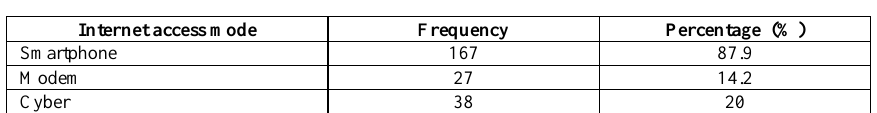
Head Teachers Mode of Internet Access Internet access mode